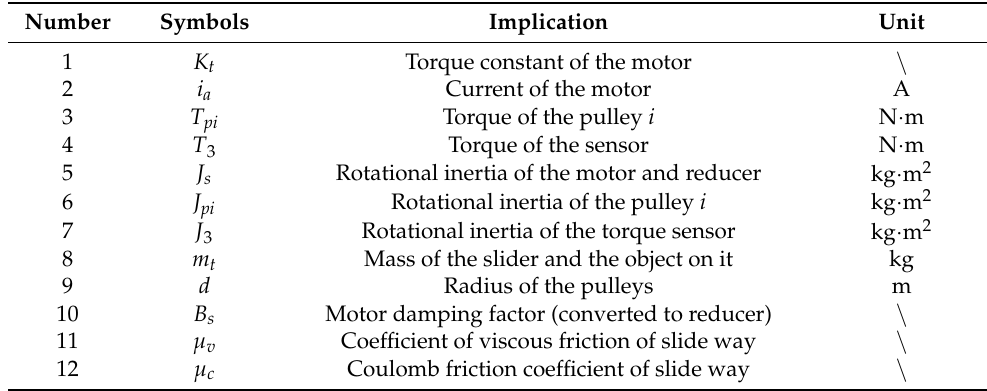
Table 3. Parameters in Equation